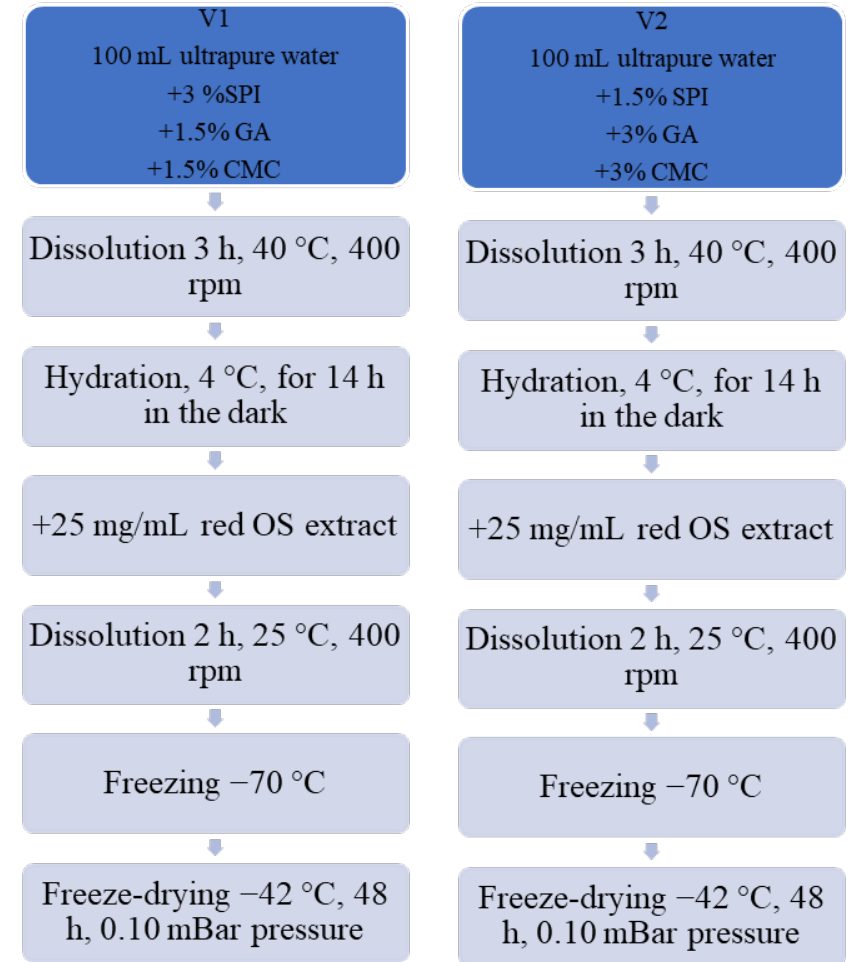
Figure 1. The red OS extract encapsulation diagram, utilizing the gelation and freeze-drying techniques .